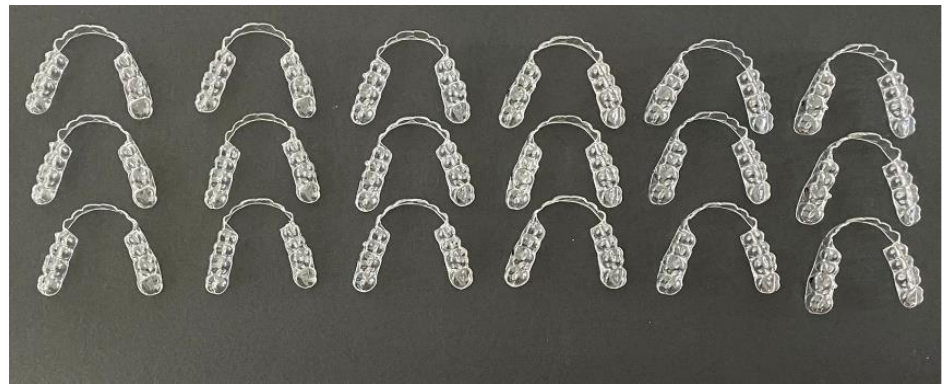
Figure 1. The 18 aligners before